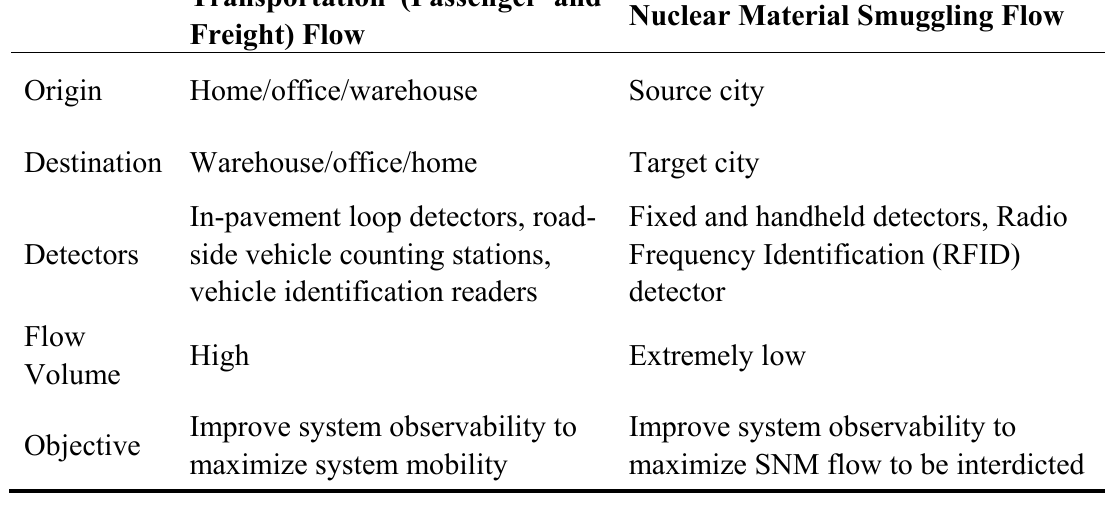
Table 1. Comparison of Transportation and SNM Smuggling